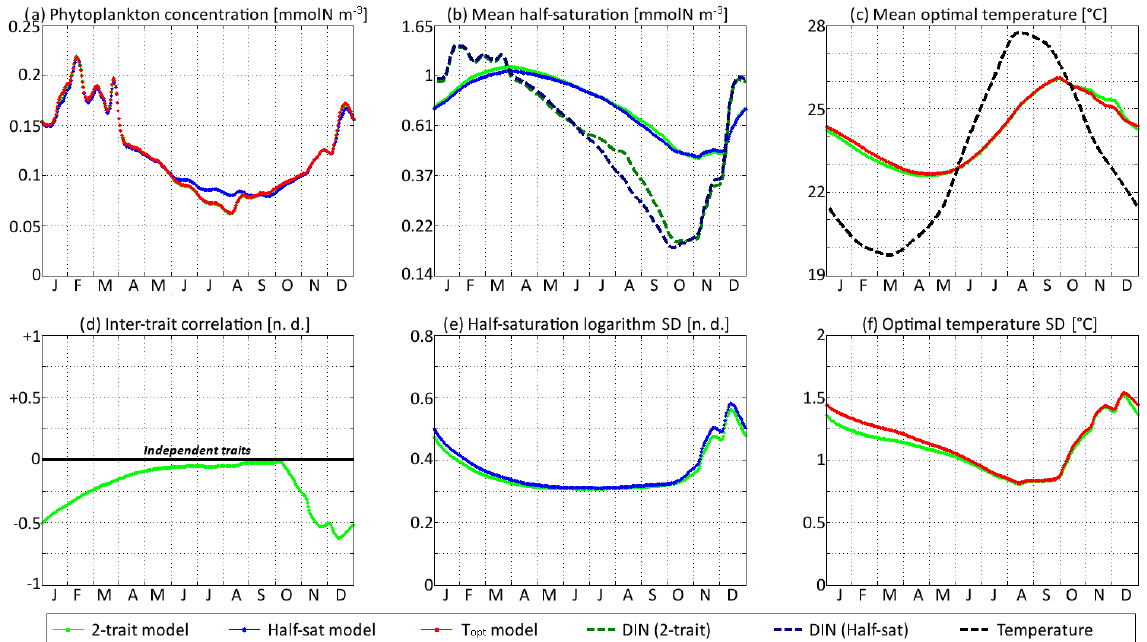
Figure 9. SPEAD state variables at the surface for ν x = 0.001 and ν y = 0 . 01 ◦ C 2 (standard) compared with the state variables of one-trait models: (a) total phytoplankton concentration, (b) (geometric) mean half-saturation, (c) mean optimal temperature, (d) inter-trait correlation, (e) half-saturation logarithm standard deviation, and (f) optimal temperature standard deviation. The dashed lines represent the environmental drivers.